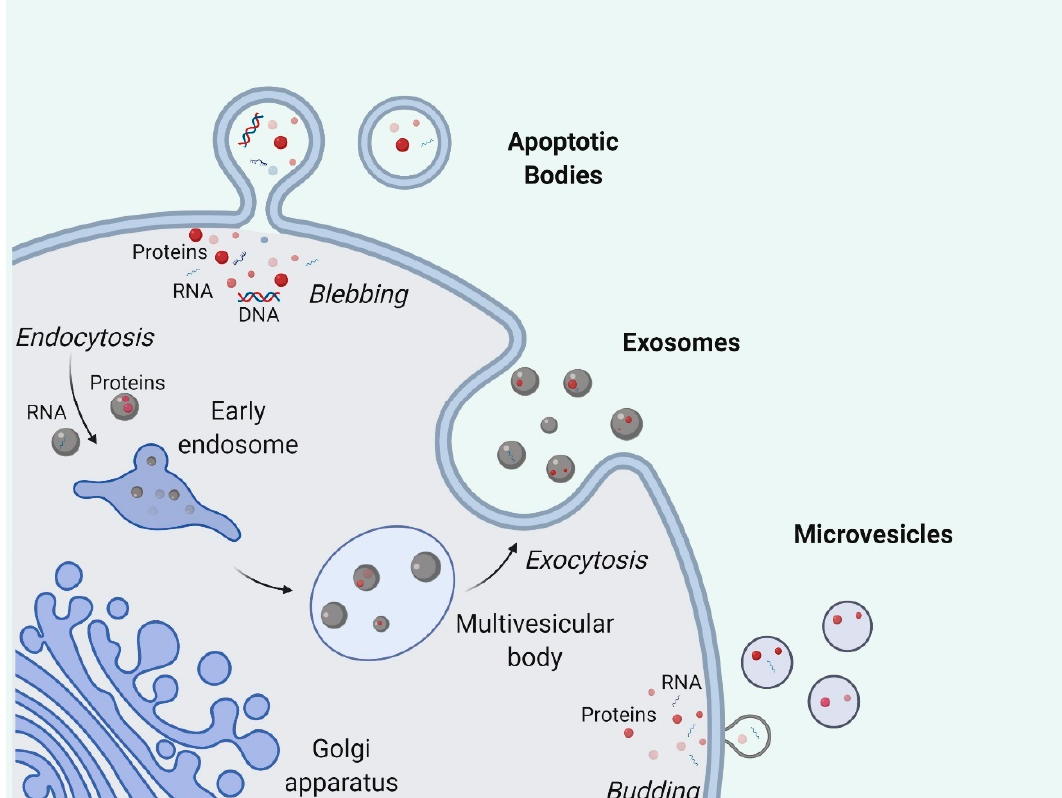
Figure 1. Biogenesis of extracellular vesicle (EV) subtypes, termed exosomes, microvesicles and apoptotic bodies. Exosomes are intraluminal vesicles which are released when a multivesicular body fuses with the cell membrane through exocytosis. Microvesicles are formed by outward shedding of the cell membrane into extracellular space. Apoptotic bodies are generated when cells undergo apoptosis. Figure was generated with BioRender.